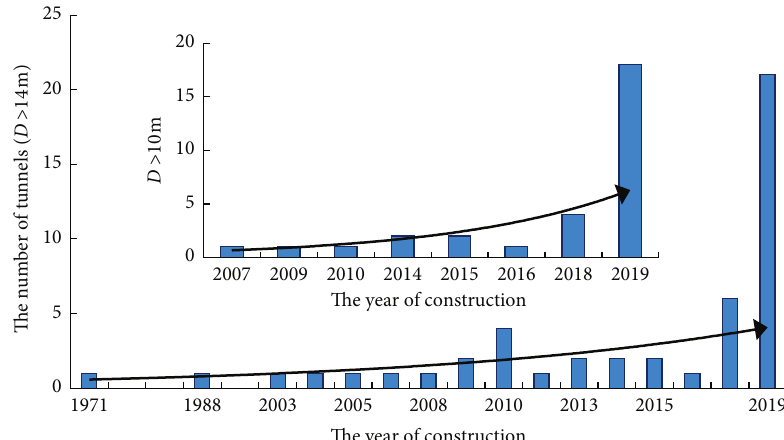
Figure 1: Construction of large-diameter cross-river/sea shield tunnels in